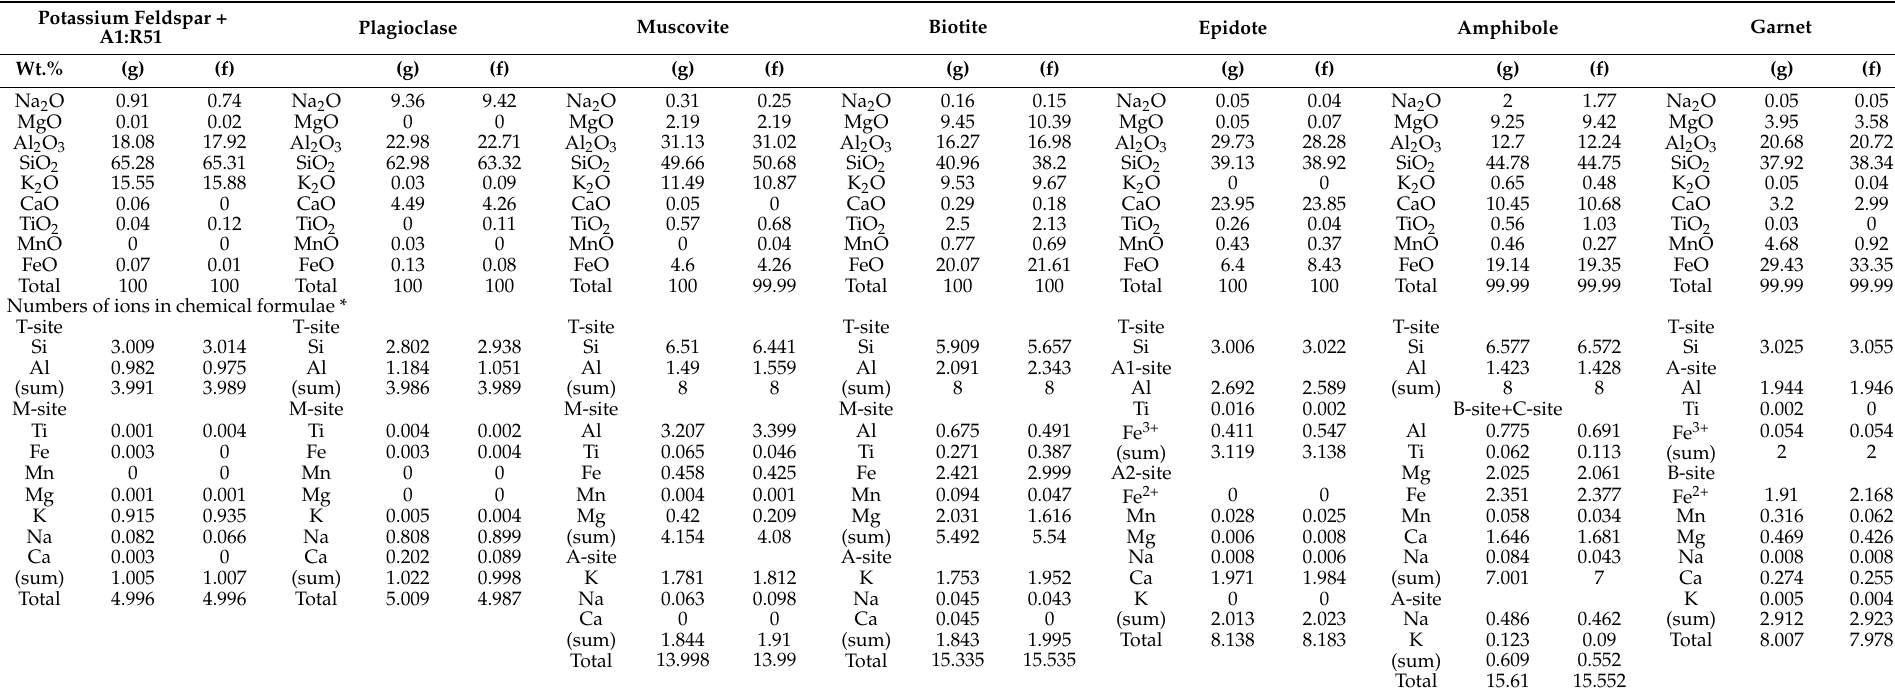
Table 2. Representative SEM–EDS analyses of minerals from pottery. Abbreviations: (g)—mineral grain; (f)—minerals in rock fragments. * Numbers of ions in chemical formulae for potassium feldspar and plagioclase were calculated on an 8 oxygen basis, for muscovite and biotite on a 22 oxygen basis, for epidote on a 12.5 oxygen basis, for amphibole on a 23 oxygen basis, and for garnet on a 12 oxygen basis, respectively. Numbers of Fe 3+ in epidote and garnet were calculated based on Fe 2+ or Fe 3+ occupancies in the cation sites and the rest as Fe 3+ or Fe 2+ in the structural formulae. ** Numbers of ions in chemical formulae for titanite on a 5 oxygen basis, for staurolite on a 24 oxygen basis, for ilmenite on a 3 oxygen basis, for rutile on a 2 oxygen basis, for zircon and magnetite on a 4 oxygen basis,